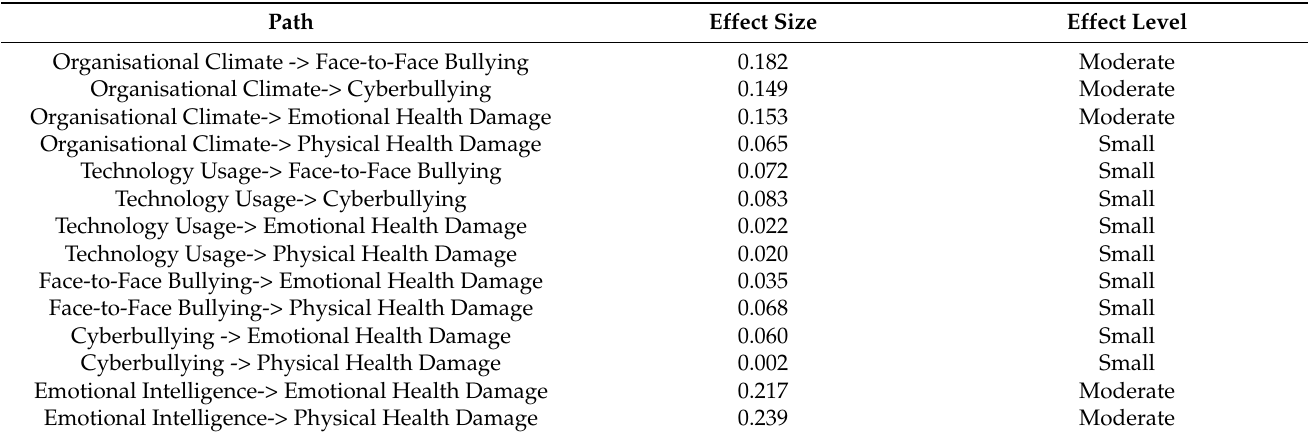
Table 4. The f 2